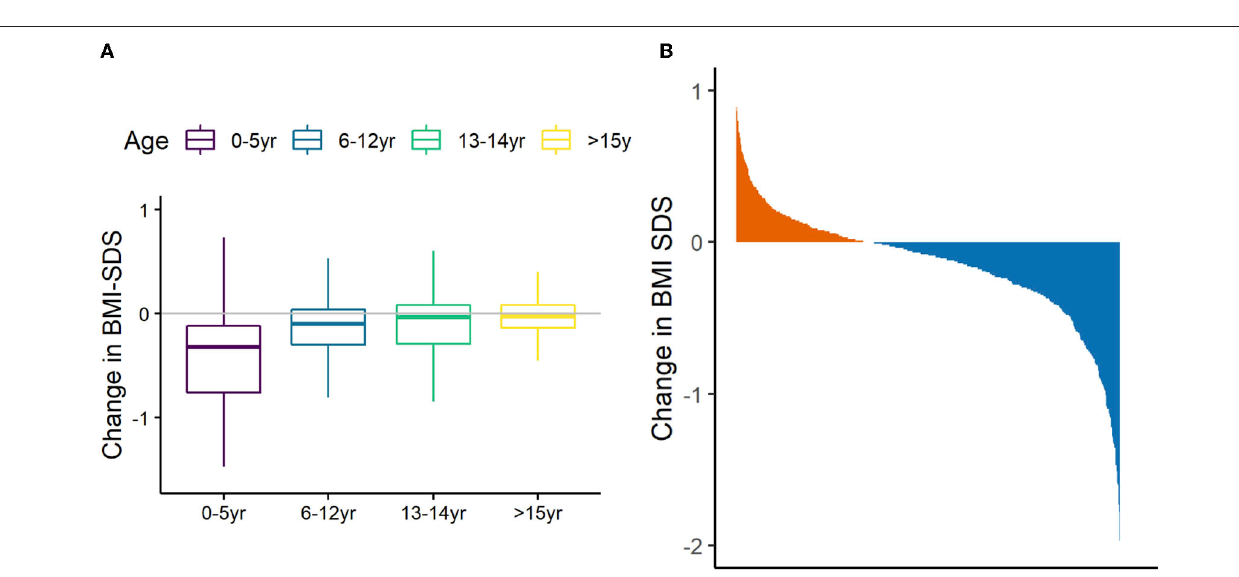
FIGURE 3 | Relationship between age and change in BMI-SDS the 692 children referred to W82GO. Data are mean (bar), interquartile range (box), and 1.5*IQR (whiskers) (A) . Waterfall plot showing overall proportion of children that had lost (blue) weight on discharge from the W82GO clinic (B)